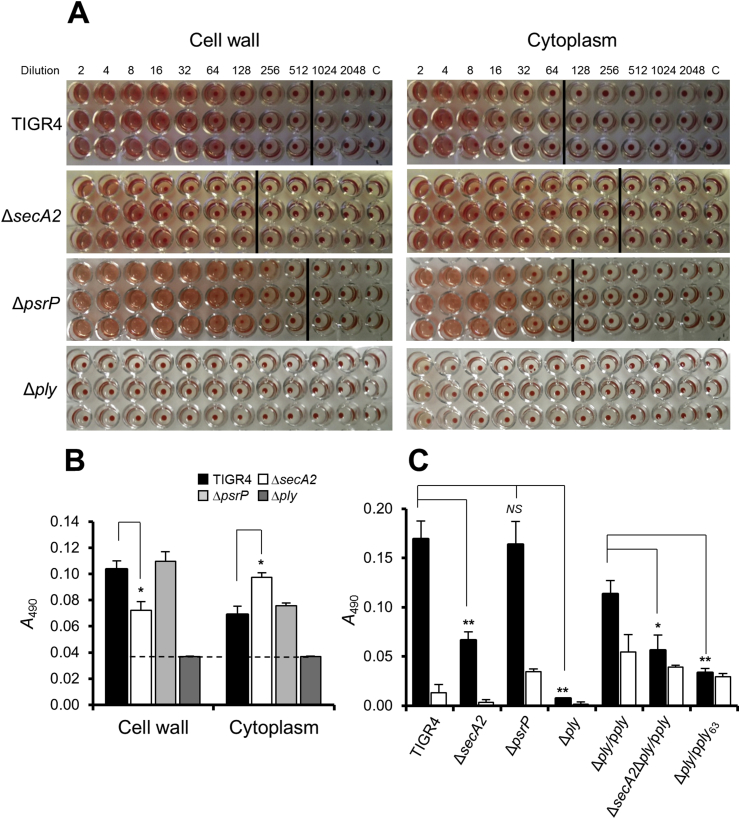
Haemolytic activities of S. pneumoniae wild type and mutants strains. (A) Bacterial cells were fractionated into cell wall or cytoplasm fractions (as indicated) and two-fold serial dilutions were incubated with 2% sheep RBCs in replicates of three. The control was assay buffer only. No pellet was considered to be 100% lysis. Vertical lines show the detection endpoints of 50% lysis. (B) Quantitative haemolytic data of the absorbance (A490) values of the first 50% lysis endpoint and the corresponding WT or mutant absorbance value at the same dilution. Therefore, absorbance values for cell wall and cytoplasmic fractions were taken at dilution factors 128 and 64, respectively. The dotted line represents the limit of detection. *P < 0.05. (n = 3). (C) Haemolytic activities of S. pneumoniae TIGR4, mutants and complemented strains after contact (sedimentation with sheep RBCs; black bars) or non-contact (incubation with sheep RBCs without sedimentation; white bars). P values: * <0.1, ** <0.05. No statistical significance to the wild type (NS) is also indicated. (n = 3).